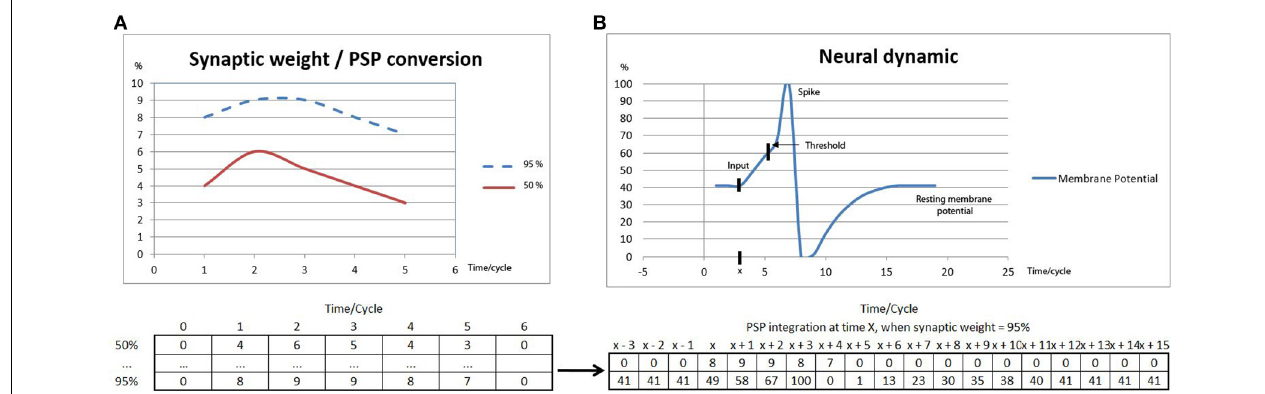
FIGURE 1 | (A) Two different samples of synaptic weight values (see Table 2 in the Supplementary material) associated to PSPs, representing the membrane potential changes integrated on a 5 cycles time duration. (B) The membrane potentialvariationresultingfromtheintegrationofaPSP(weight = 95%)which